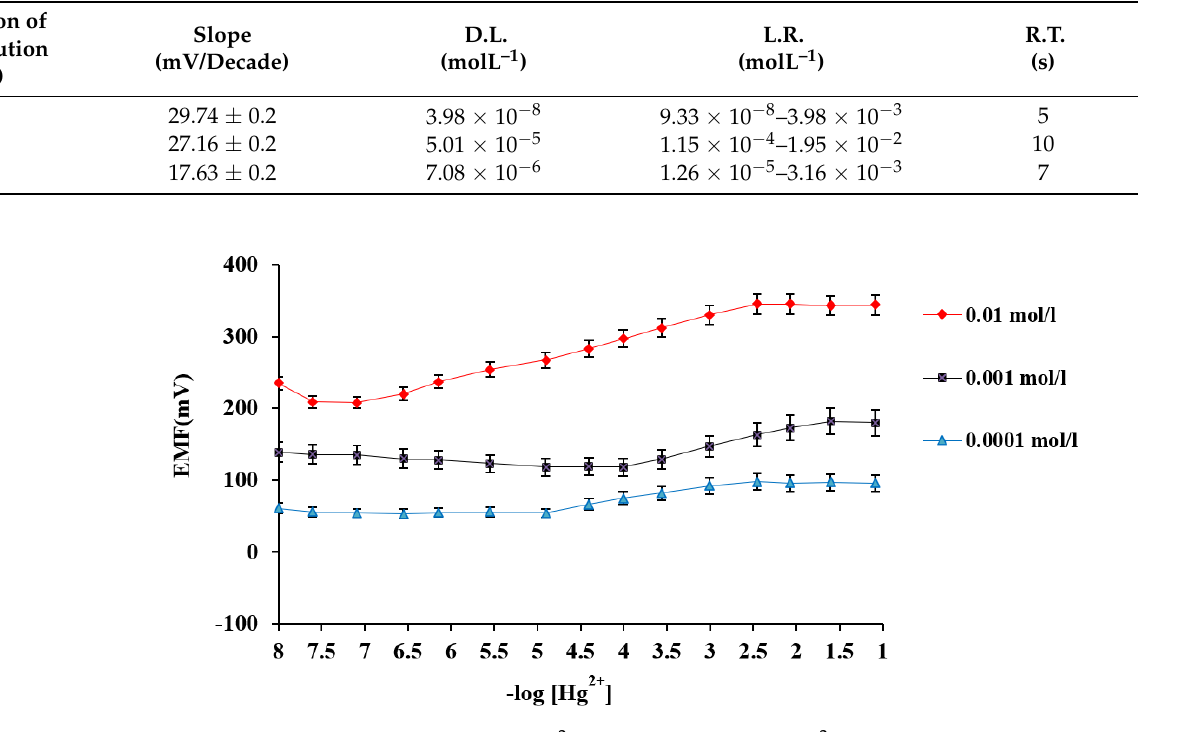
Figure 7. Role of test solution’s pH on the potential response of Hg 2+ –SE at different concentrations: (blue) 1.0 × 10 –2 and (red) 1.0 × 10 –3 molL –1 . 3.6. Response Time of the Proposed Hg 2+ –SE The response time of the proposed Hg 2+ –SE was investigated at a different concen- tration of Hg(NO 3 ) 2 (1.0 × 10 −7 –1.0 × 10 −4 molL –1 ). The potential versus response time was plotted in Figure 8. The response time of developed Hg 2+ –SE becomes fast upon the concentration increases. However, the response of the electrode reached a steady-state potential in less than 10 s after analyte addition. The steadiness attained in a short re-